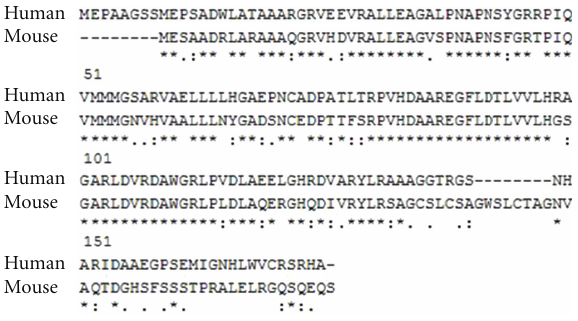
Figure 1: Alignment of aa sequences of human and murine p16 INK4A using ClustalLW computer program. Identical and similar aa residues are marked by asterisks and dots,